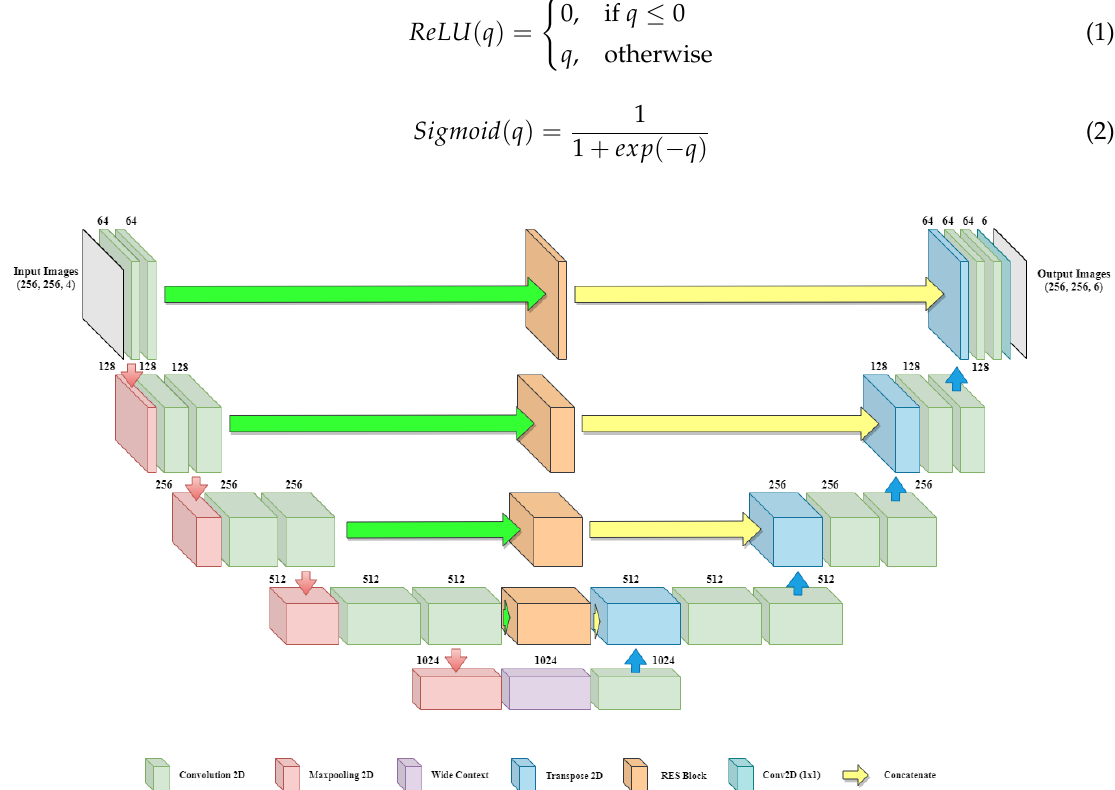
Figure 2. Overall architecture of the proposed BU-Net including RES blocks and wide context